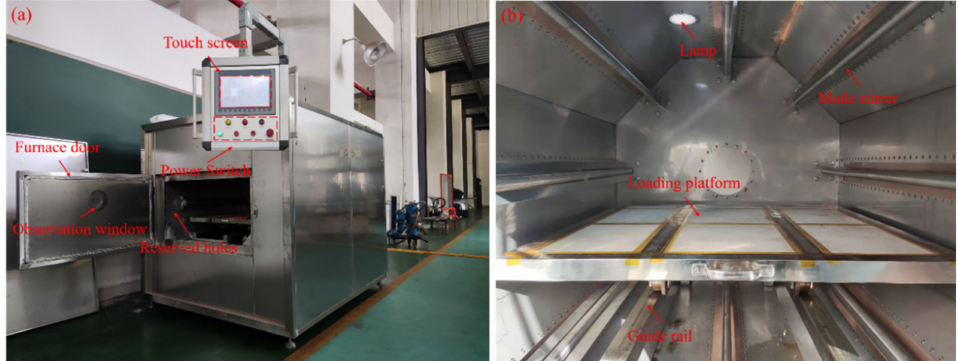
Figure 13. Regulating device of microwave heating uniformity: ( a ) exterior of the device; ( b ) internal structure of the